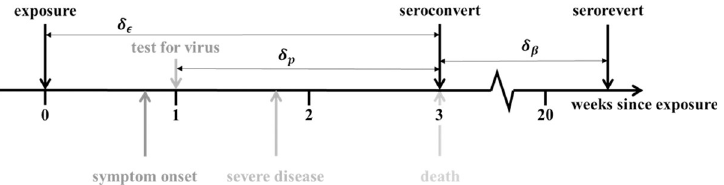
Fig 1. Progression of exposed individuals through the various clinical (below the timeline) and diagnostic (above the timeline) stages of infection and recovery. Stages marked in grey represent events that may happen, with a probability consistent with the darkness of the shade of